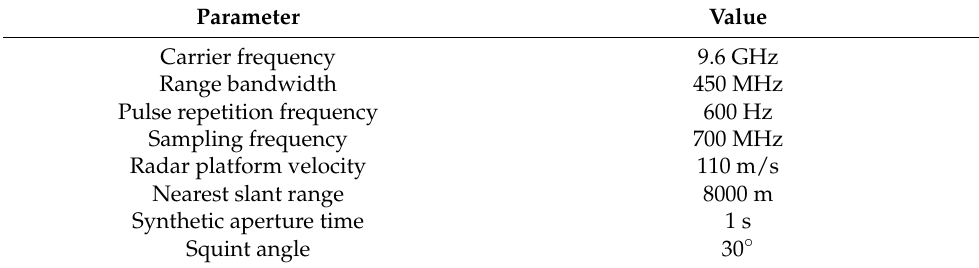
Figure 10. Imaging model of a ship target of the second simulation: ( a ) 3 - D model of the ship target; ( b ) Geometric model of the simulation. Table 1. Simulation radar parameters.